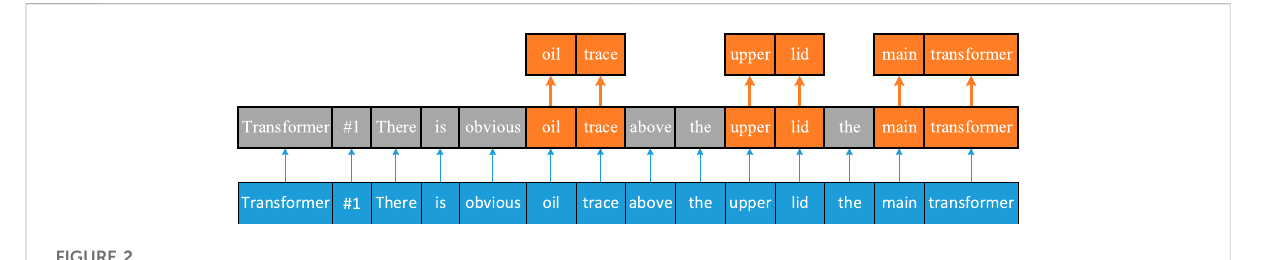
FIGURE 2 Example of rule-based defect text knowledge